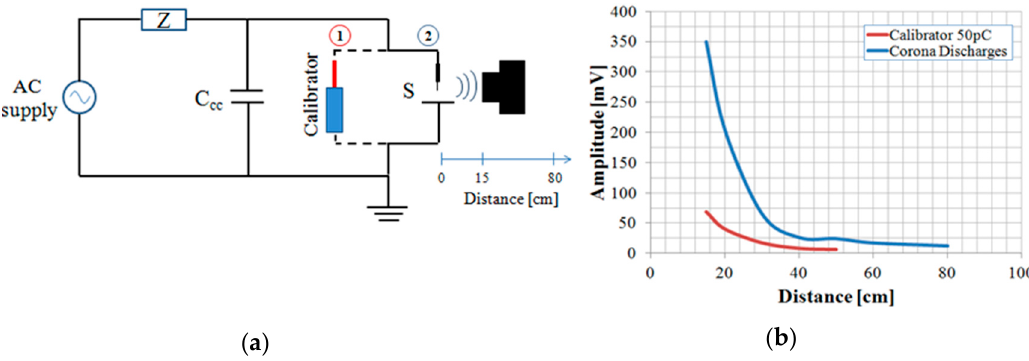
Figure 7. Measurements with the corona emulator and calibrator at different distances from the discharge source: ( a ) Measurement circuit; ( b ) results.